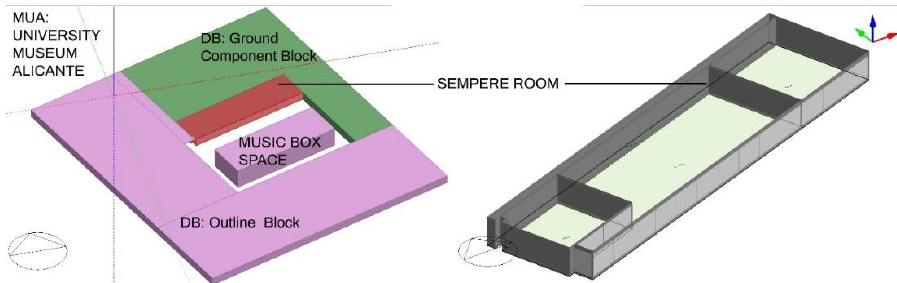
Figure 8. Model of the MUA in the Design Builder program and the hall under the water-covered roof.